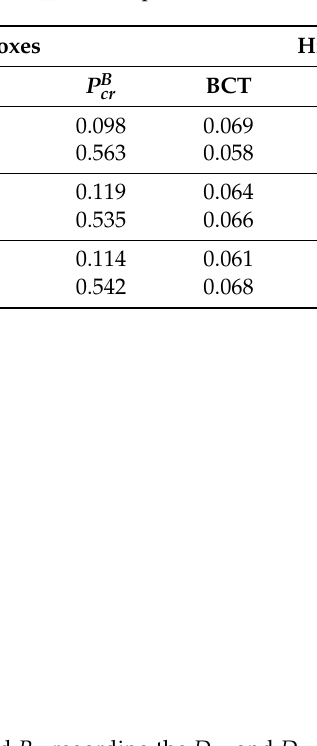
Table 4. Sensitivity of BCT and P cr regarding the D 11 and D 22 perturbation of an EB corrugated cardboard.